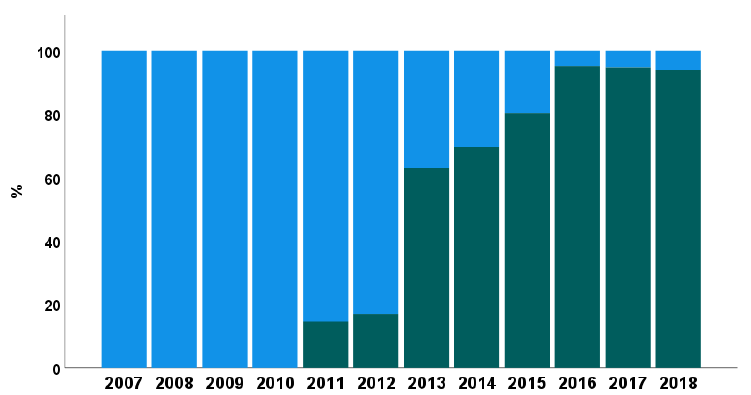
Figure 1. Bar chart showing the percentage of patients treated according to the recommendations of the endocarditis team over the years, from 2007 to 2018. Blue: patients not managed according to endocarditis team recommendations. Green: patients managed according to endocarditis team recommendations.